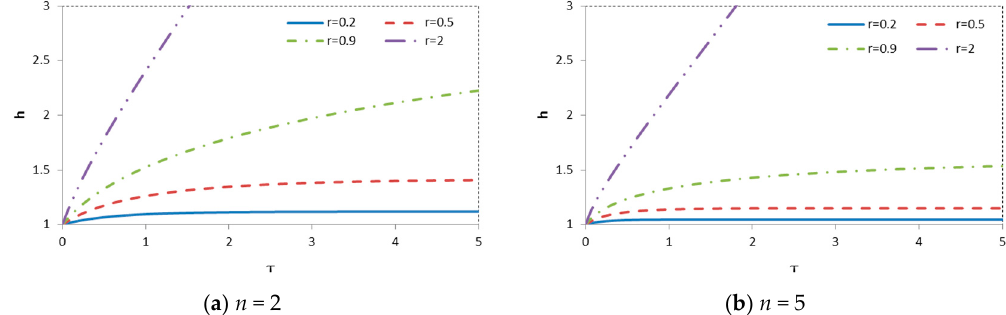
Figure 5. Transient development for various sea-level rise (SLR) rates starting from equilibrium state ( h (0) = 1). Influence of the power n can be seen by comparing the two panels, ( a ) for n = 2 and ( b ) for n = 5.